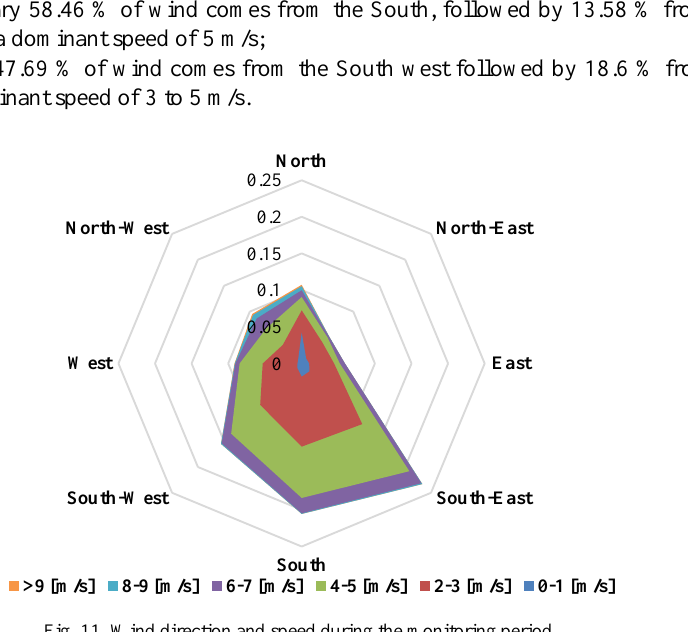
Fig. 11. Wind direction and speed during the monitoring period. Fig. 12 present relative humidity and temperature measurements during the monitoring period.